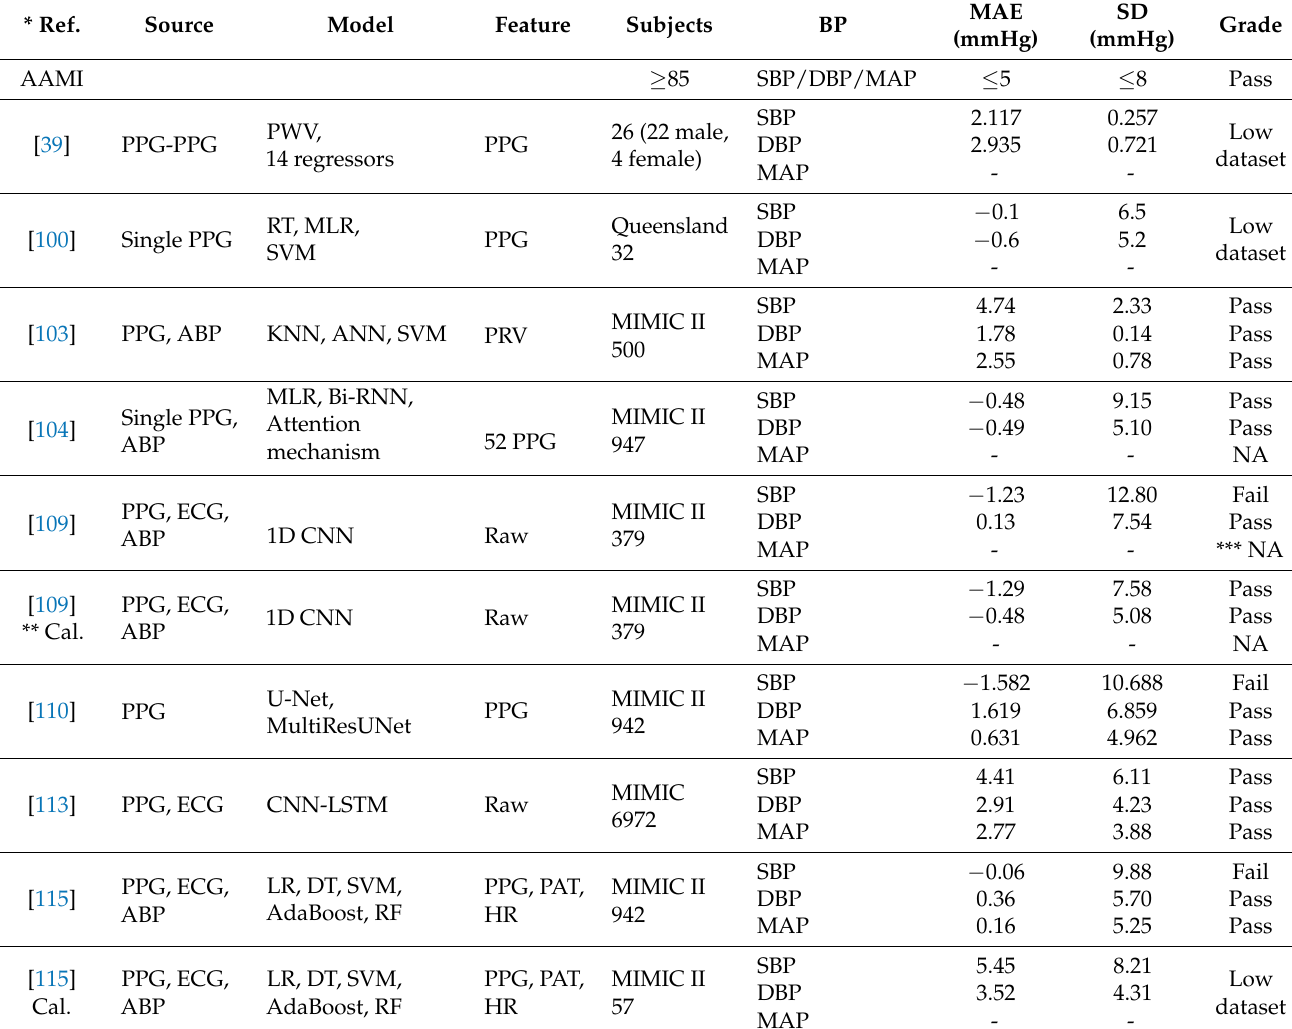
Table 1. Validation of algorithms based on AAMI